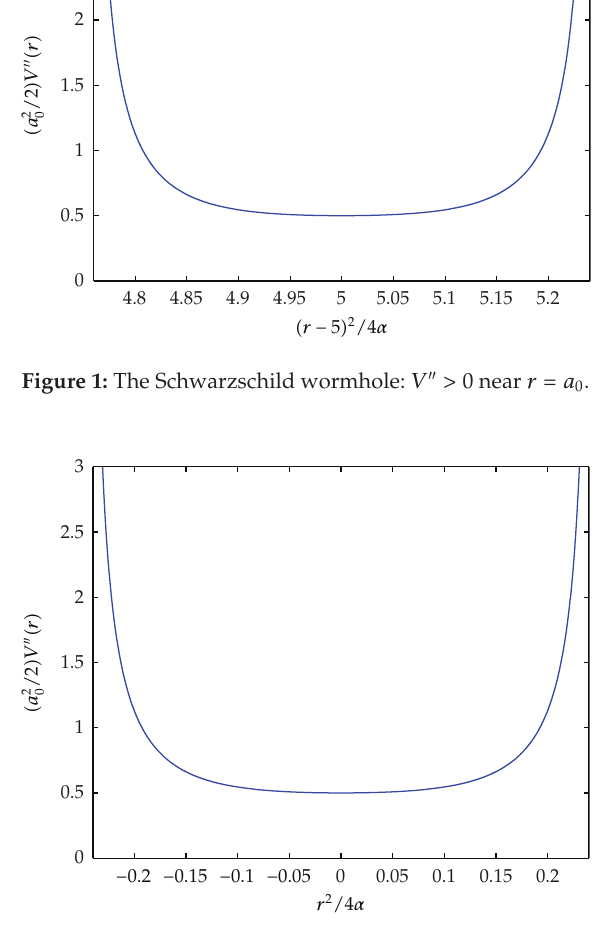
Figure 2: The graph of Figure 1 moved a 0 units to the